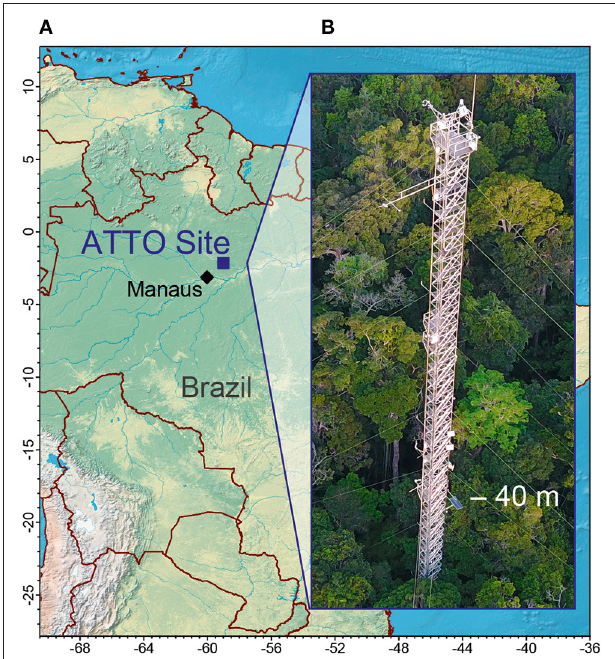
FIGURE 1 | (A) Location of the ATTO site. (B) 80m walk-up tower with inlet at 41m height above ground level.